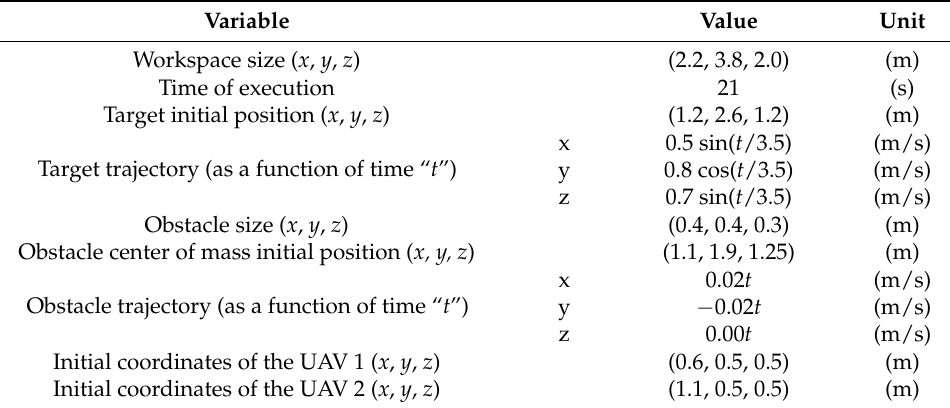
Table 3. Technical data of the proposed